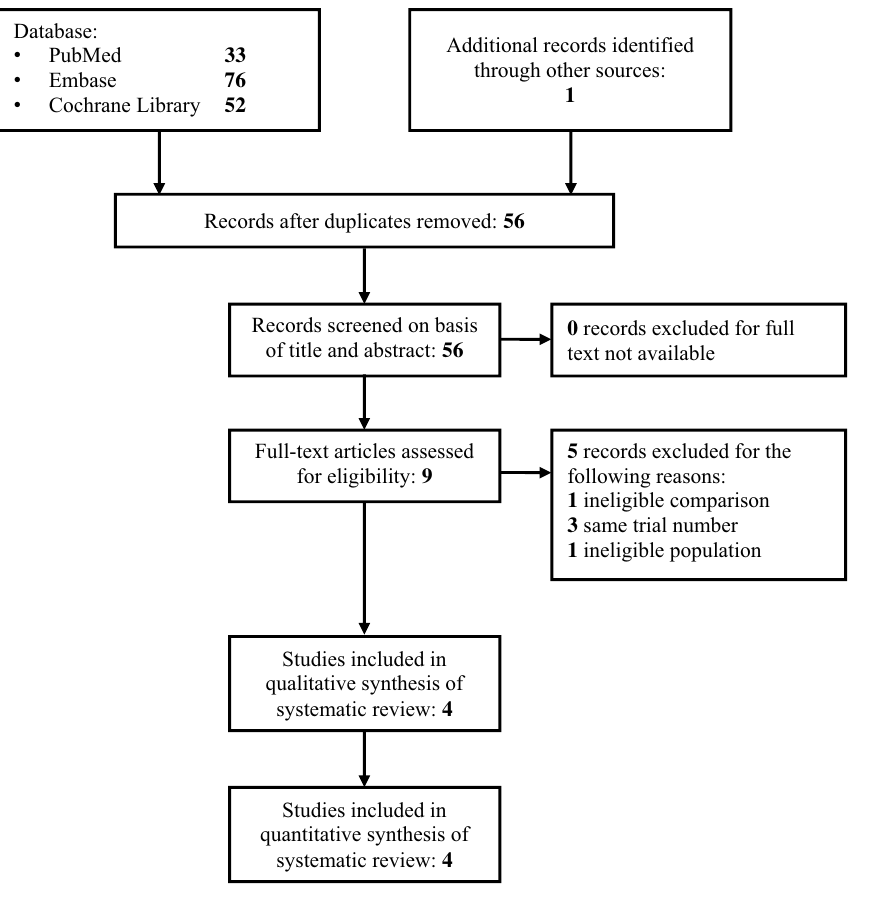
Figure 1. Flow chart of primary studies